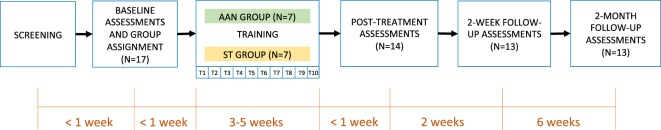
Flow diagram describing progression of subjects through the study.